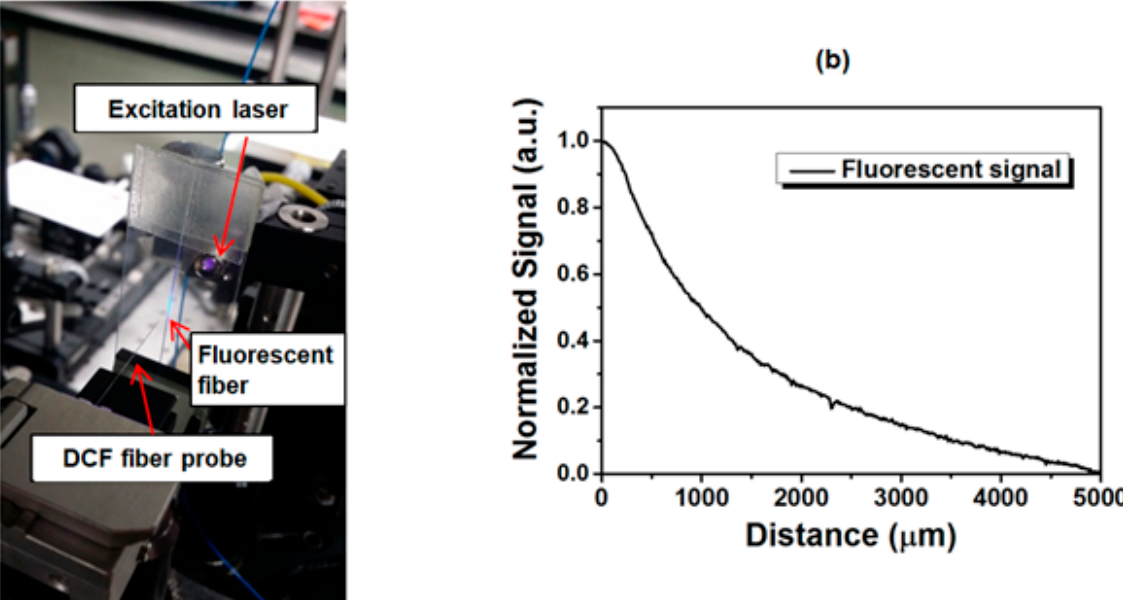
Figure 7. ( a ) Photograph of the experimental setup for measuring the reduction in fluorescence signal corresponding to the distance. ( b ) Measurement results: normalized fluorescence emission signal according to the distance from the DCF probe tip.